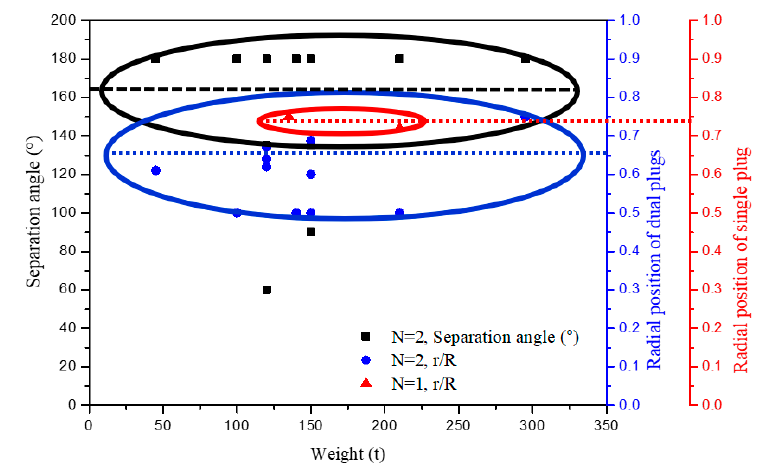
Figure 15. Collection of optimal radial position and separation angle of plugs in ladles with various weights. (Points with black color, blue color, and red color represent the data of dual plugs’ separation angles, radial positions of dual plugs, and radial positions of single plug, respectively. The color of point is same as that of the axis.)